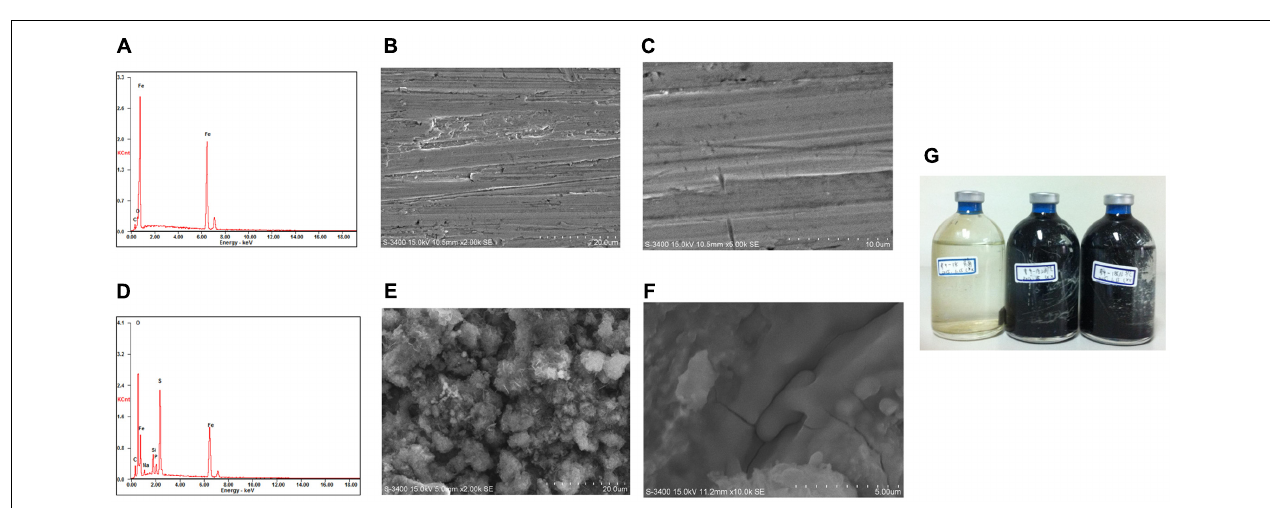
FIGURE 3 | Energy-dispersive X-ray spectrometer (EDS) and scanning electron microscope (SEM) images of surface of carbon steel coupon before exposure (A–C) and an example after exposure (D–F) in production water environment after 28 days incubation; picture of incubations after 300 days (G) .